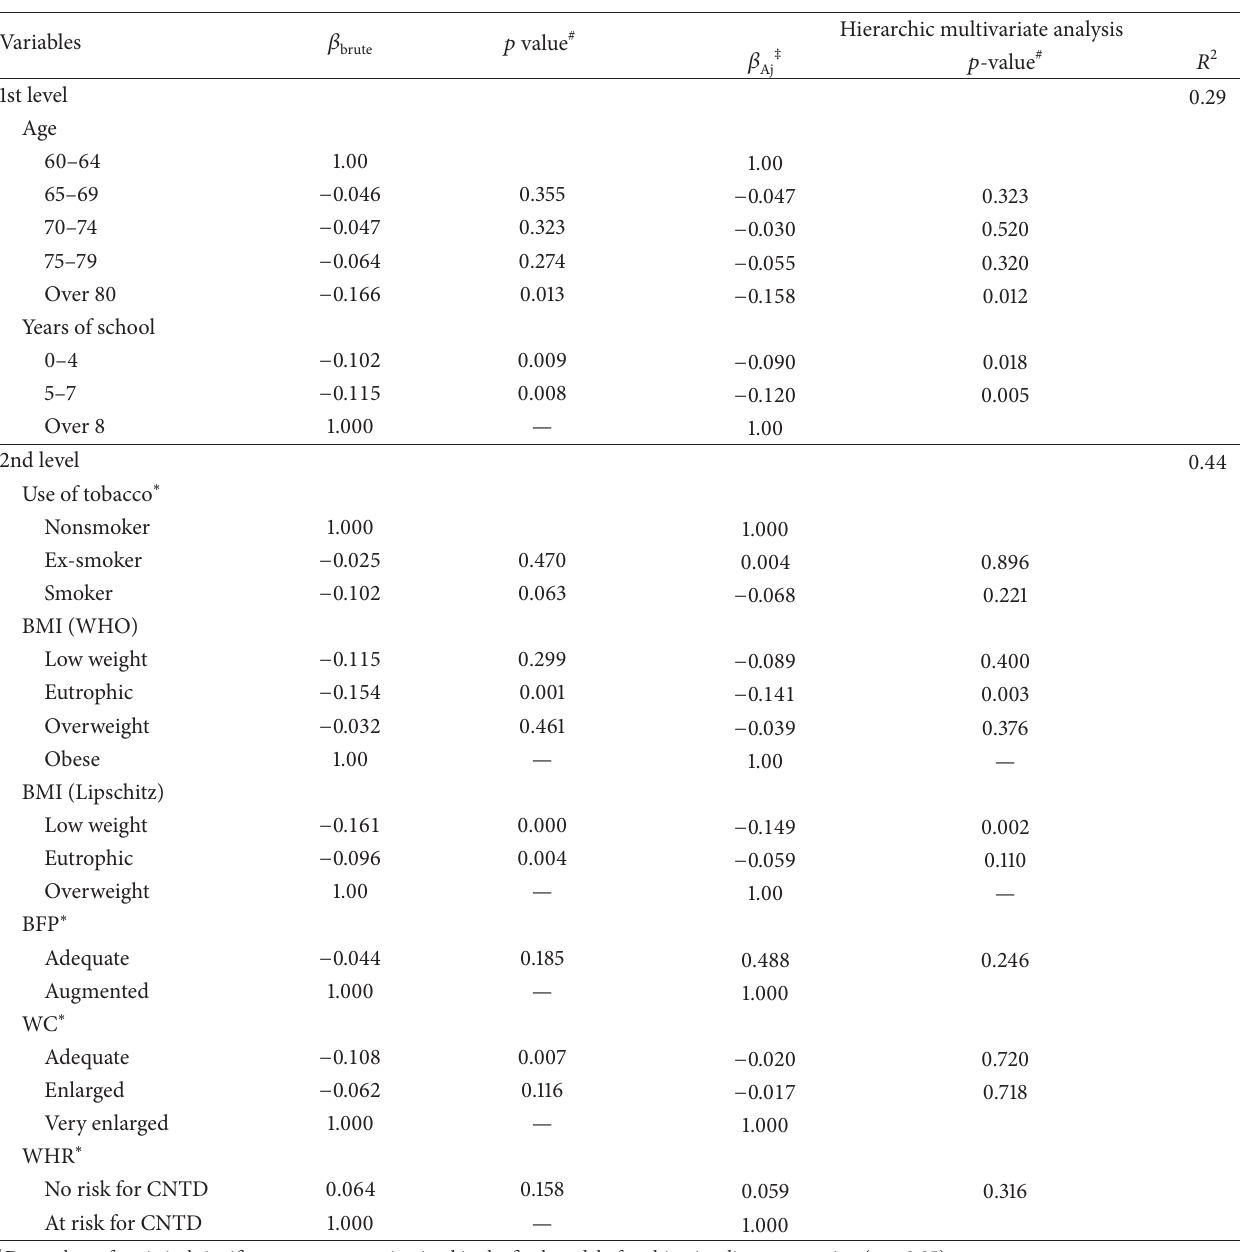
Table 4: Linear regression coefficients (brute and adjusted) for bone mineral density according to sociodemographic, lifestyle, anthropomet- ric, and body composition variables, in elderly men. Goiˆania, GO, 2009. 𝑛 = 132